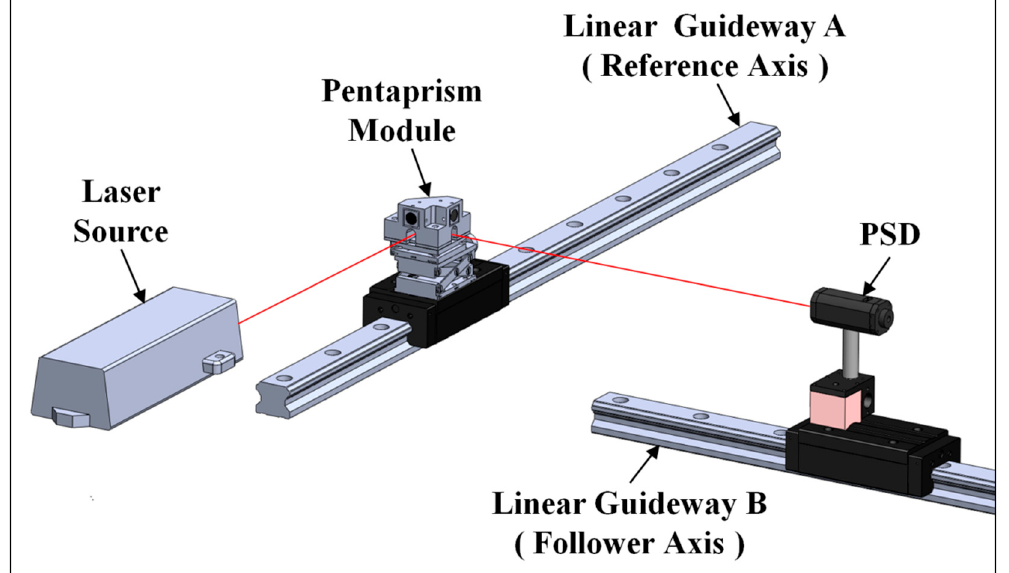
Figure 5. Schematic diagram of the perpendicularity module.